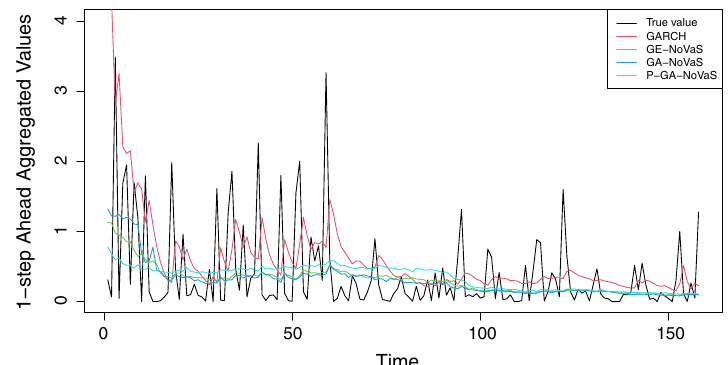
Fig. 5 The curves of different methods’ 1-step ahead aggregated predictions on volatile CADJPY data and actual values